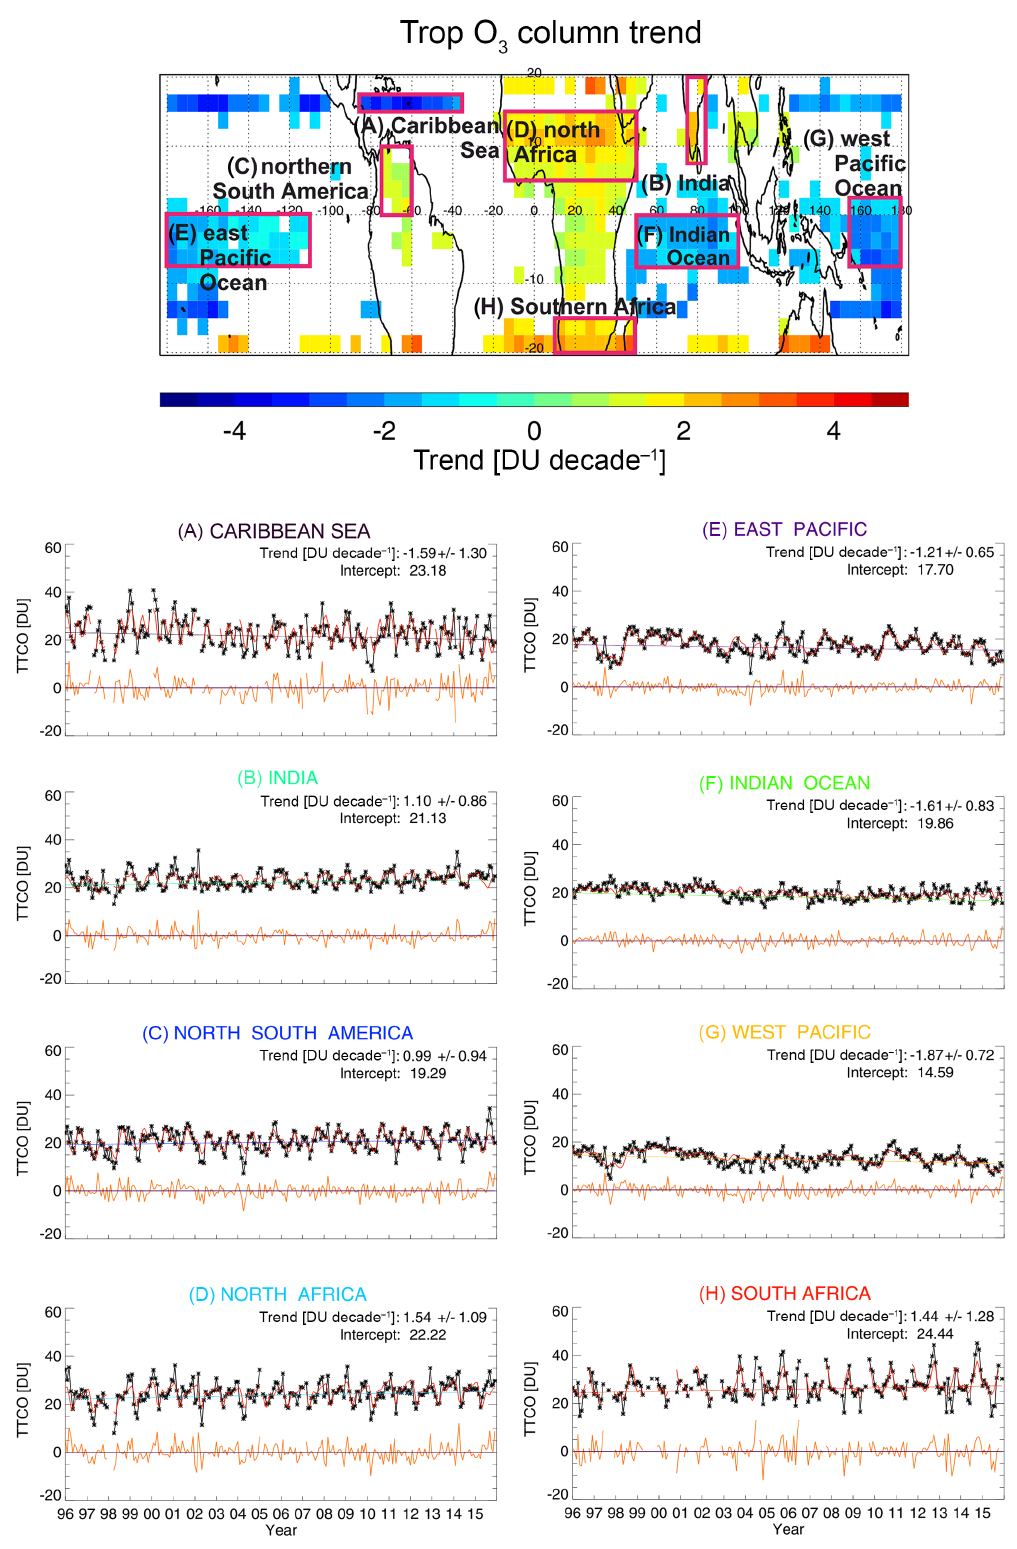
Figure 5. Tropical tropospheric ozone trend in (A) Caribbean Sea, (B) India, (C) northern South America, (D) north Africa, (E) east Pacific Ocean, (F) Indian Ocean, (G) west Pacific Ocean and (H) southern